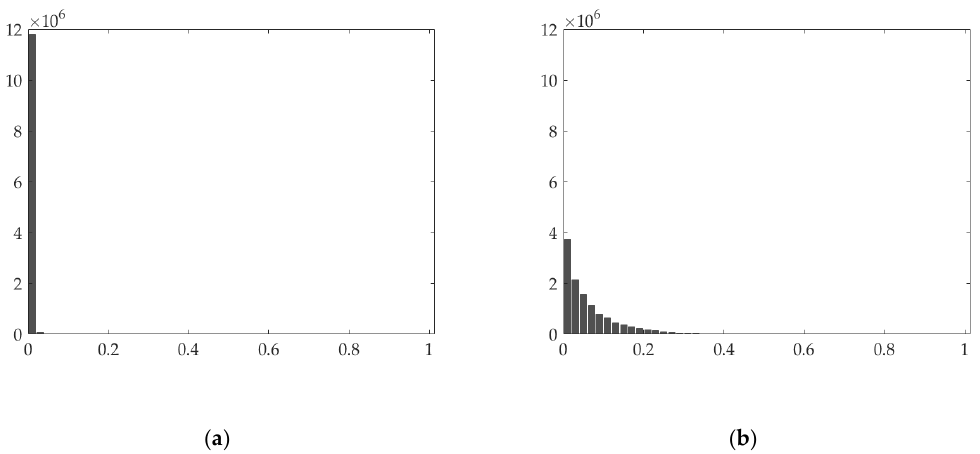
Figure 3. The histogram of the absolute values of the horizontal gradient of ( a ) cloud/shadow element and ( b ) clean element.